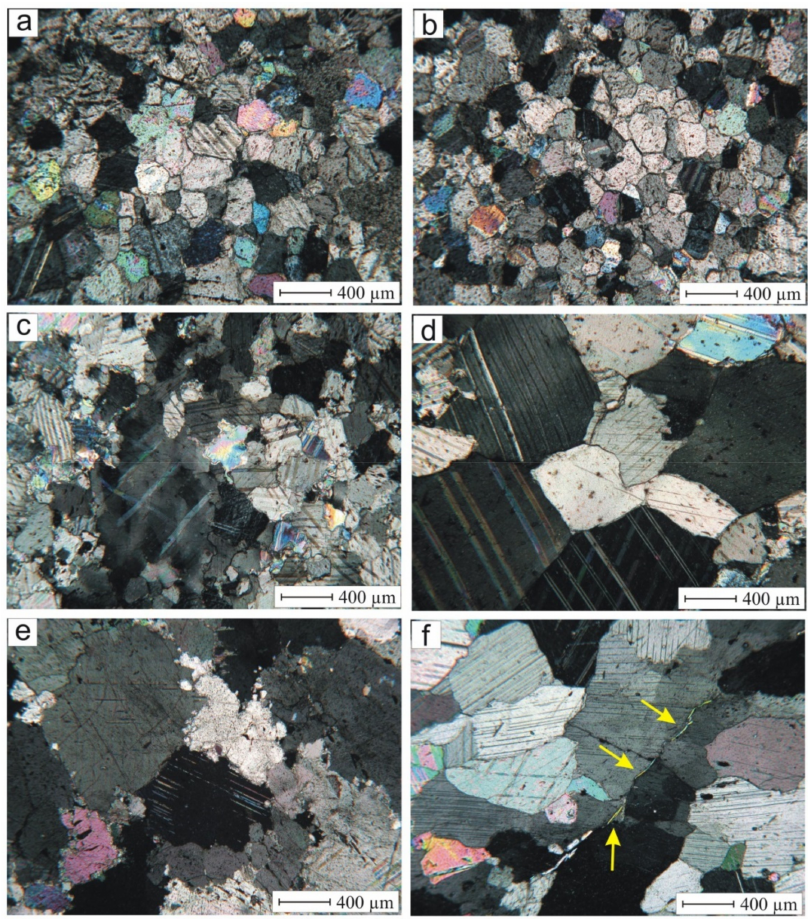
Figure 3. Microphotos in thin section by polarized optical microscopy, images under crossed nicols. ( a ) Sample C2; ( b ) Sample C11; ( c ) Sample C13; ( d ) Sample C14; ( e ) Sample C18; ( f ) Sample C20, where microcrystals of white mica are